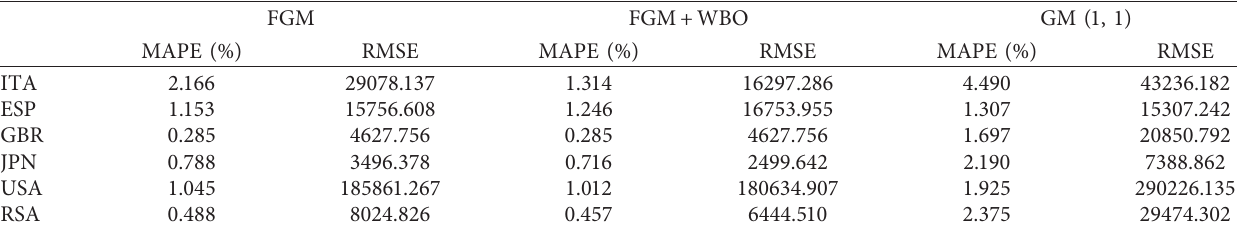
Figure 9: The prediction performance after the government’s control measures took effect (part 2). Table 5: The prediction performance in the second